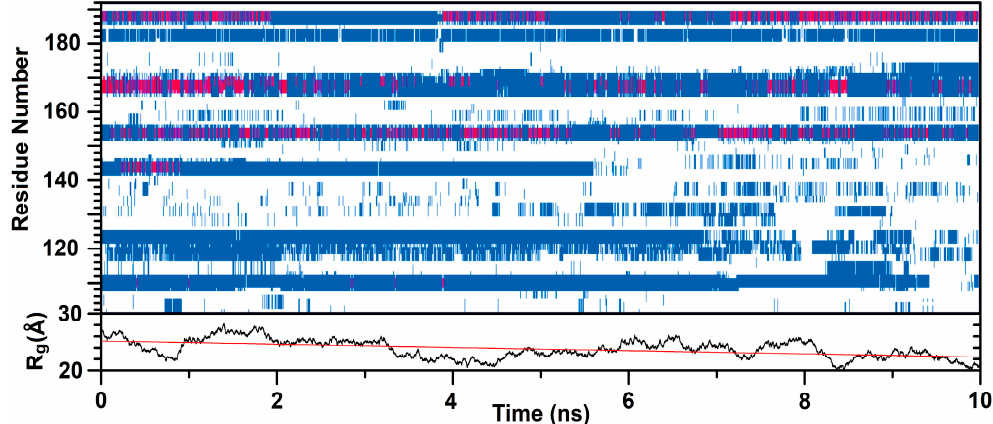
Figure 3. Simulated secondary structure and radius of gyration of C-LrtA: Backbone properties of the protein without the His-tag are calculated in a 10 ns time interval, following 15 ns of equilibration after starting from an elongated conformation. ( Up ) Secondary structure propensities calculated with VMD [25]: (Blue) β -structure, (red) helical structure, and (white) random coil; ( Down ) Radius of gyration of C-LrtA; the drift leading to a small decrease of R g is also shown (red line).